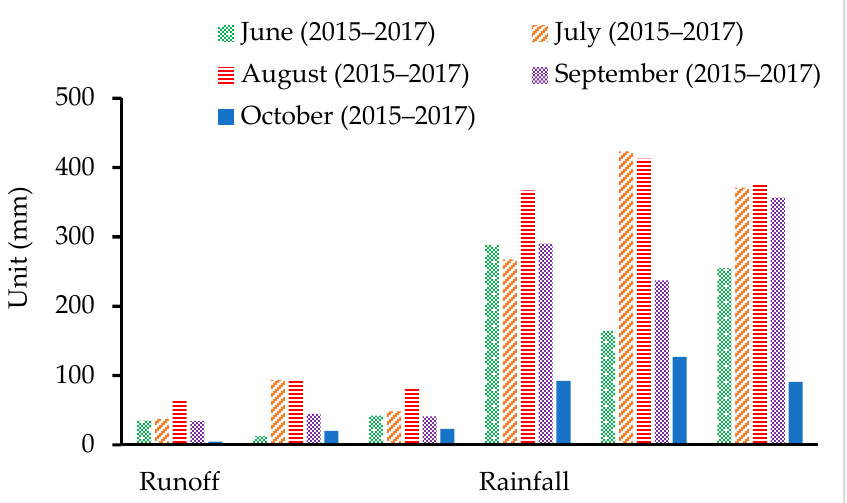
A stage–discharge relationship (Figure 7) was developed and used to convert the